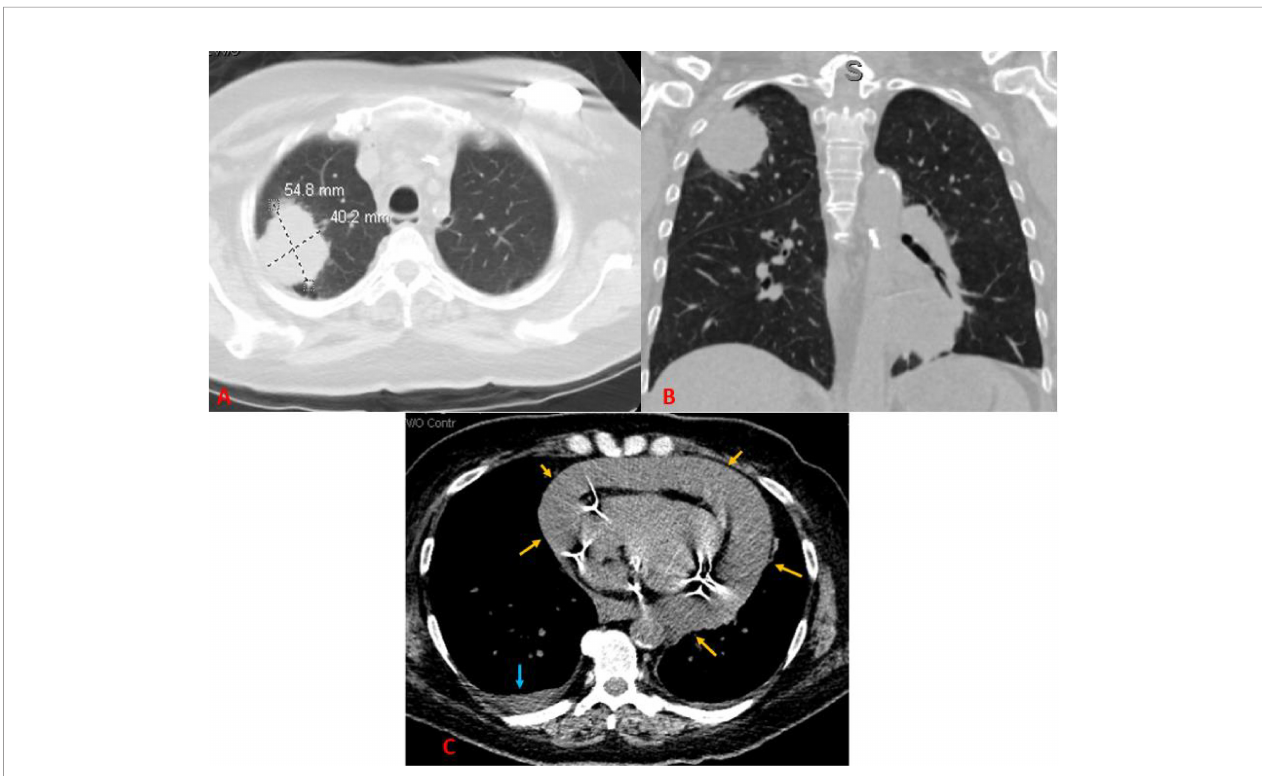
FIGURE 1 | A CT scan of the chest without contrast. (A) Axial image showing a right upper lobe mass measuring approximately 5.5 × 4.0 cm in maximum axial dimensions. (B) Coronal image showing the right upper lobe mass contacting the pleura. (C) Axial image showing a large pericardial effusion (yellow arrows) and a small right pleural effusion (blue